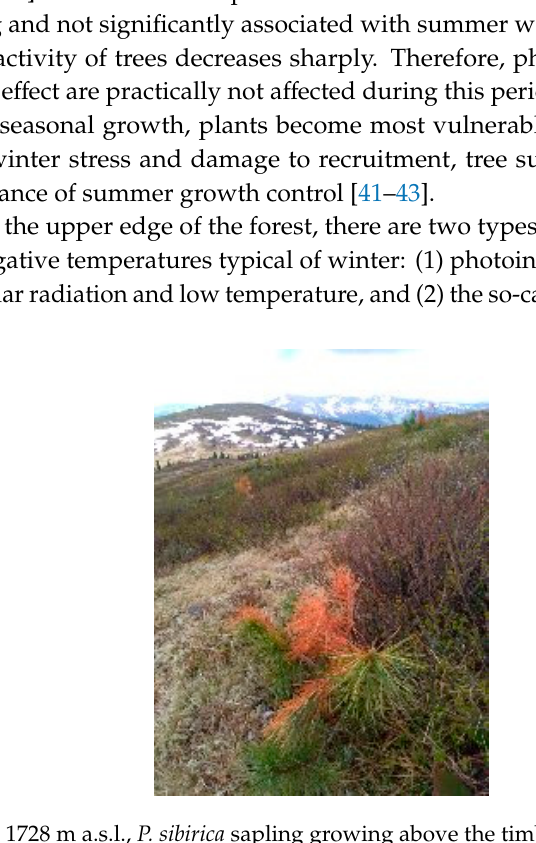
Figure 8. Altitude 1728 m a.s.l., P. sibirica sapling growing above the timberline. Brown dead needles are likely a result of winter desiccation.